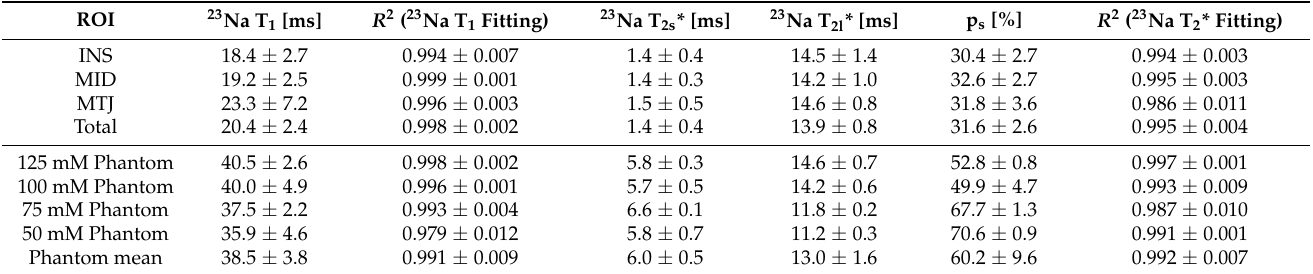
Table 1. Fitting results for 23 Na relaxation times measured in three healthy controls in the different Achilles tendon (AT) regions of interests (ROIs) and 4% agarose phantoms with different 23 Na concentrations.